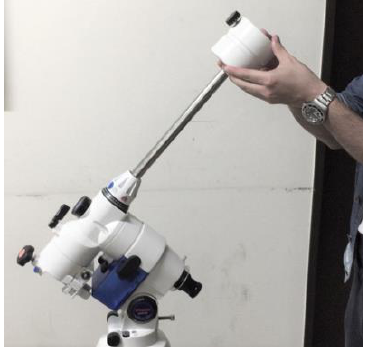
Figure 1. Unsafe attachment of counterweight